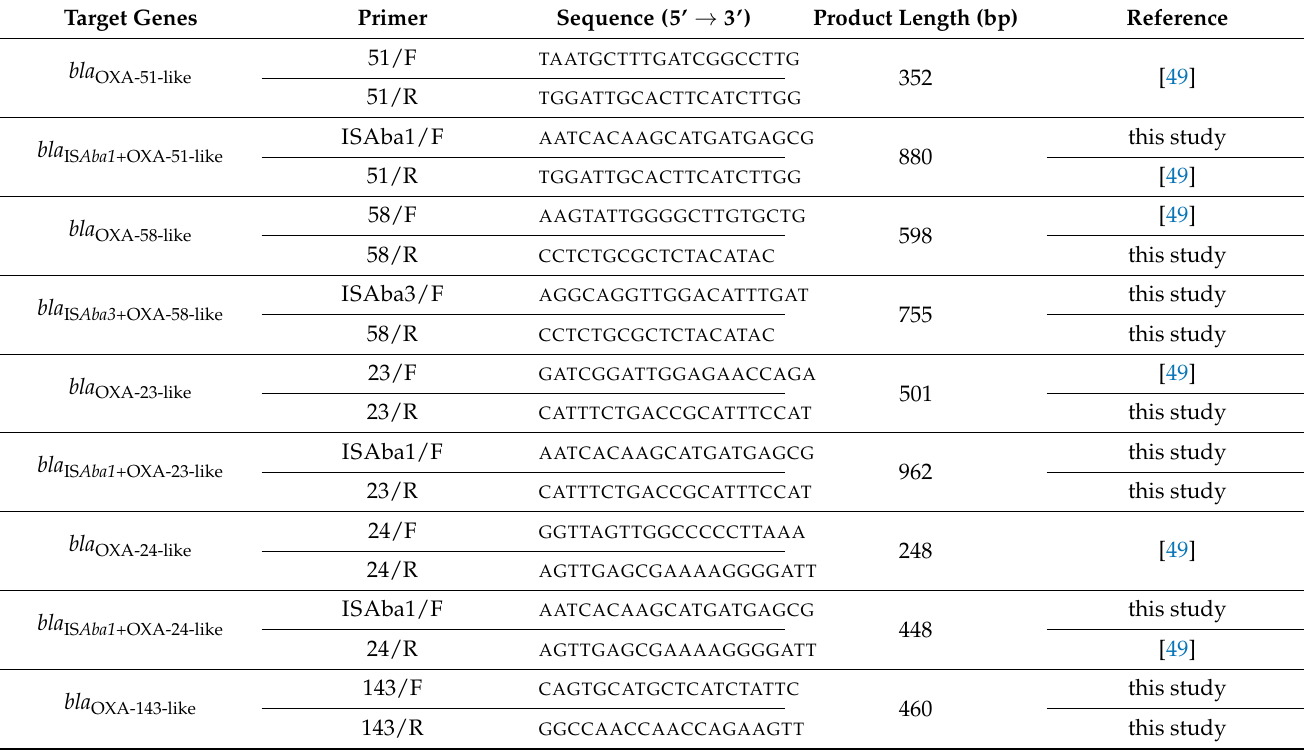
Table 4. Primers used for